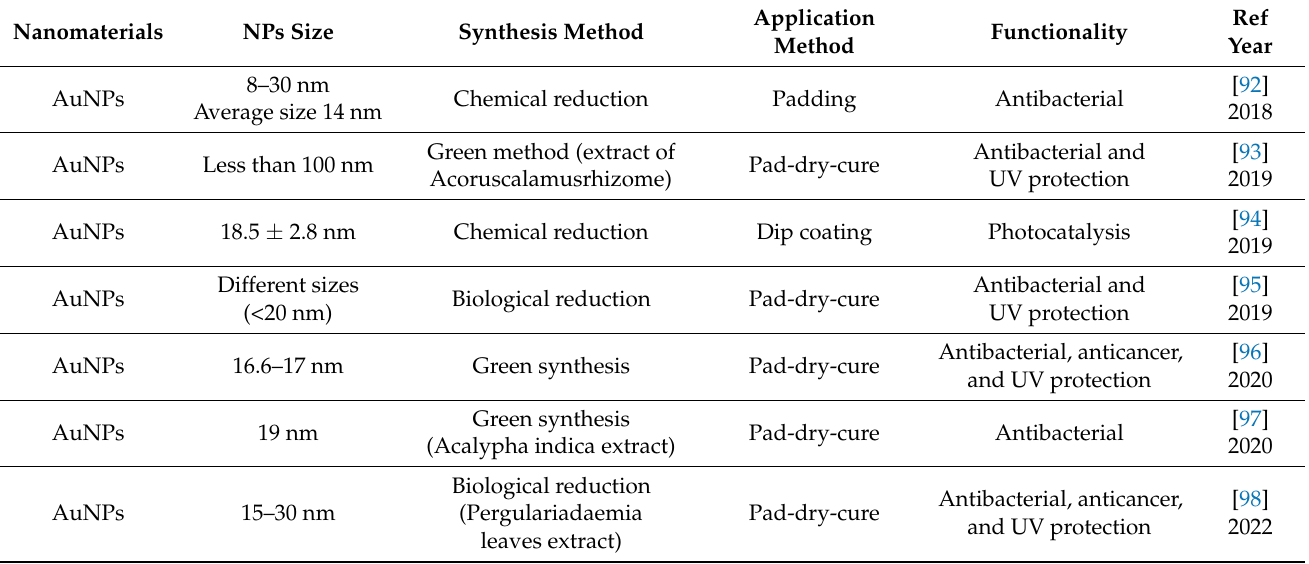
Table 6. Summary of the functionalization of cotton fabrics with